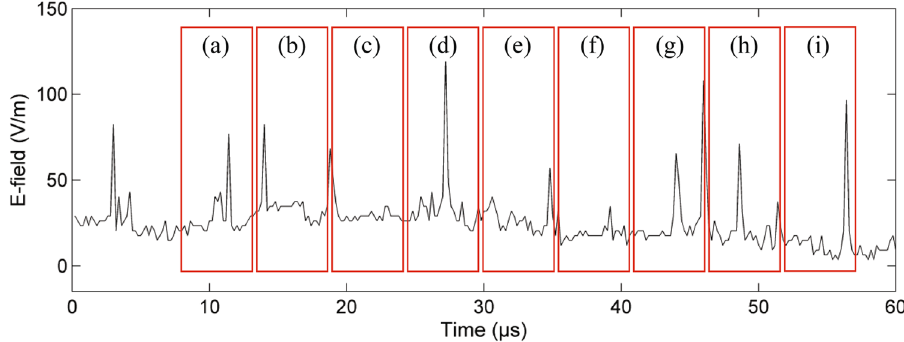
Figure 7. The surface electric field changes of the leader development shown in Fig. 3, with exposure time of each frames marked with red